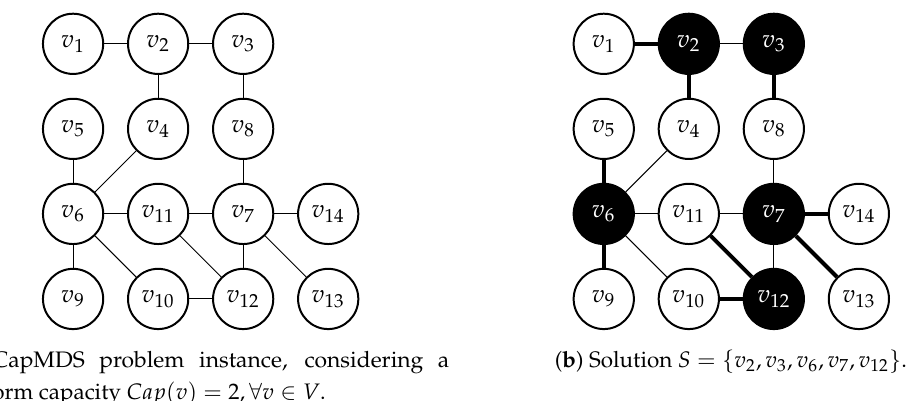
Figure 1. An example of the CapMDS problem. Note that the bold edges in ( b ) indicate the domination relations. Vertices v 1 and v 4 , for example, are dominated by vertex v 2 which forms part of the